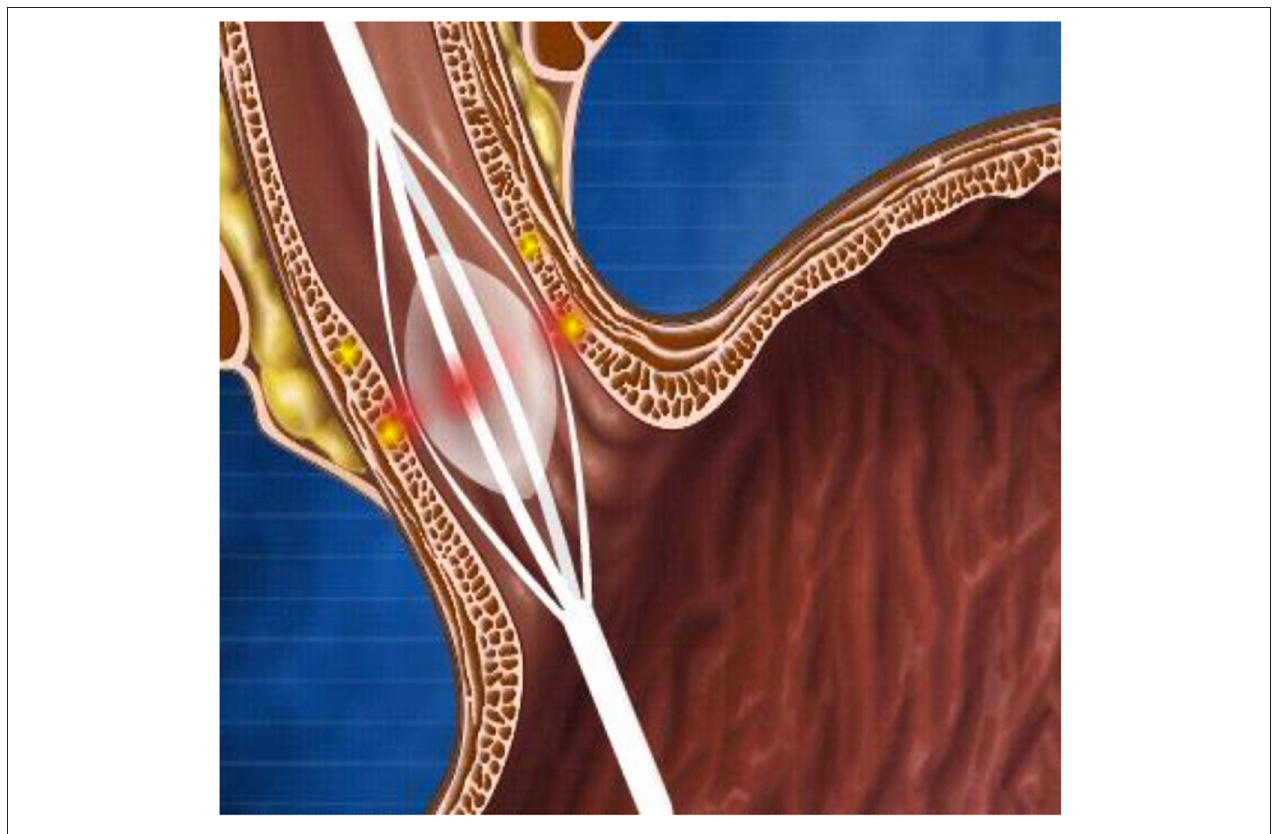
FIGURE 7 | The Stretta ®